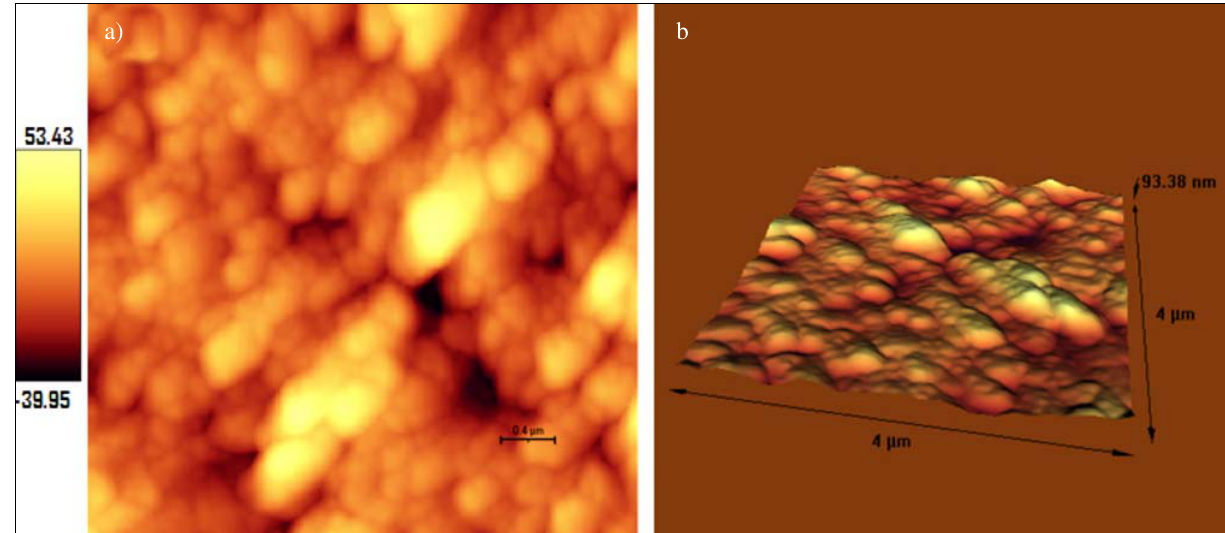
Figure 7. (a) and (b) AFM images of the Ag NPs.